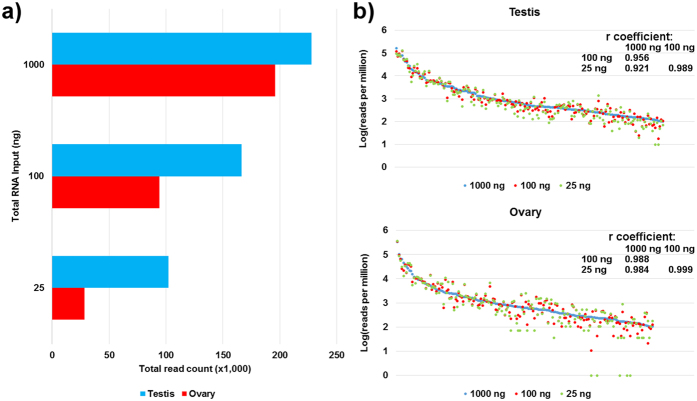
Efficiency of low-input RNA library preparation.(a) Total number of miRNA reads obtained from libraries prepared using different total RNA inputs. (b) Normalized miRNA reads from total RNA low-input libraries plotted against the data derived from the standard 1000 ng total RNA input library. Pearson’s product-moment correlation coefficient r is given for miRNAs with a threshold abundance >100 reads per million.